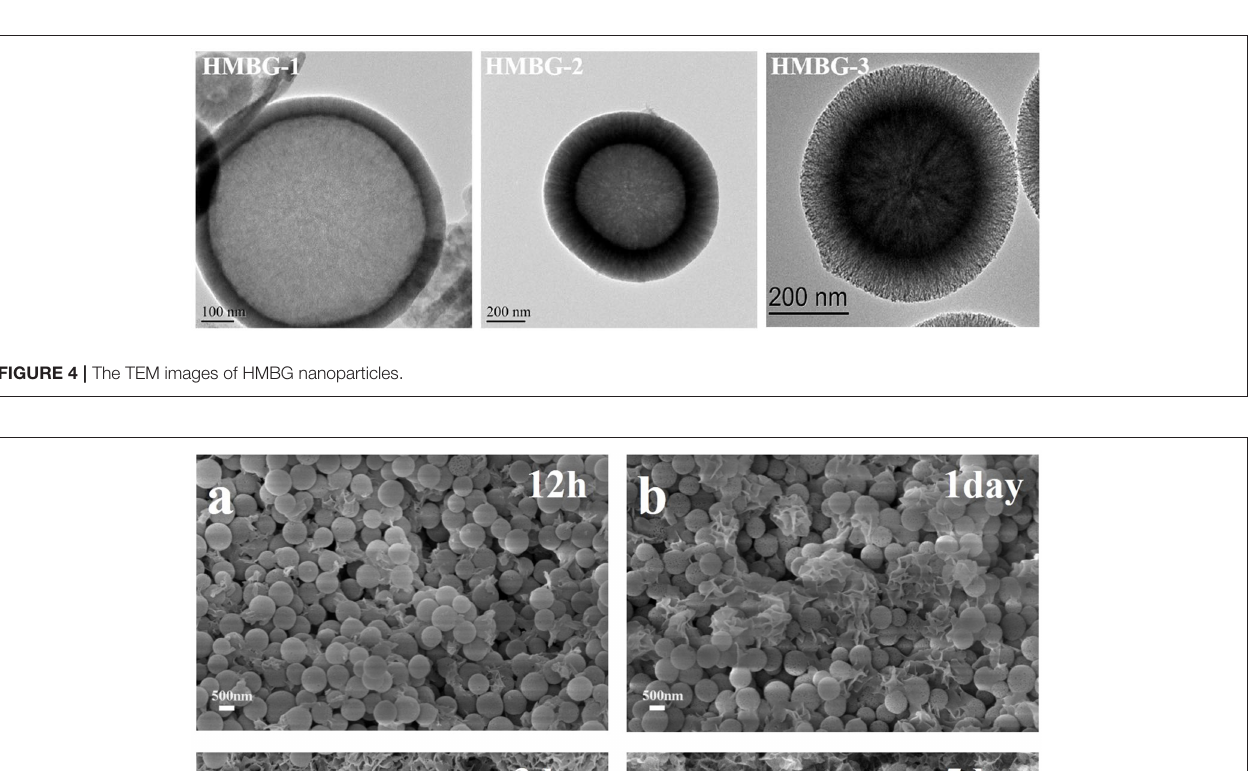
After soaking, new peaks were observed at 2 θ = 26 ◦